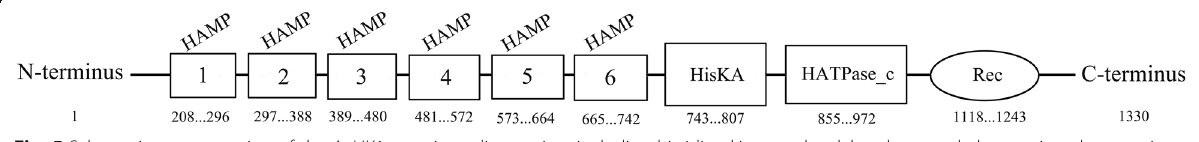
Fig. 5 Schematic representation of the AaHK1 protein coding region, including histidine kinase, adenylyl cyclase, methyl-accepting chemotaxis protein, and phosphatase domain repeats (HAMPs); His kinase A (phospho-acceptor) domain (HisKA); HK-like ATPase domain (HATPase_c); and response regulator domain